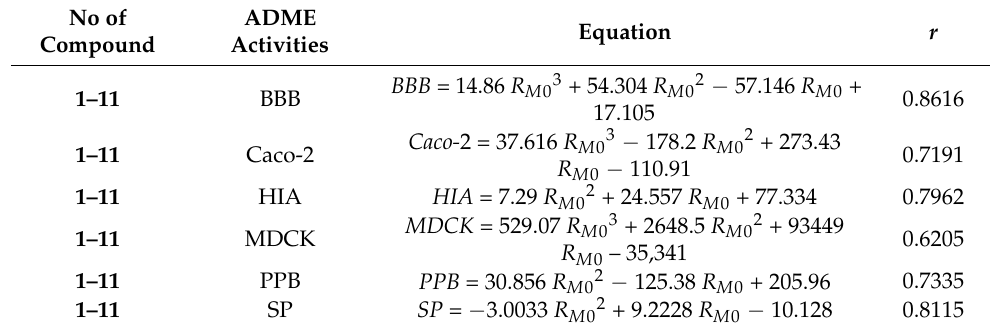
Table 7. The correlation of the R M 0 values with the predicted ADME